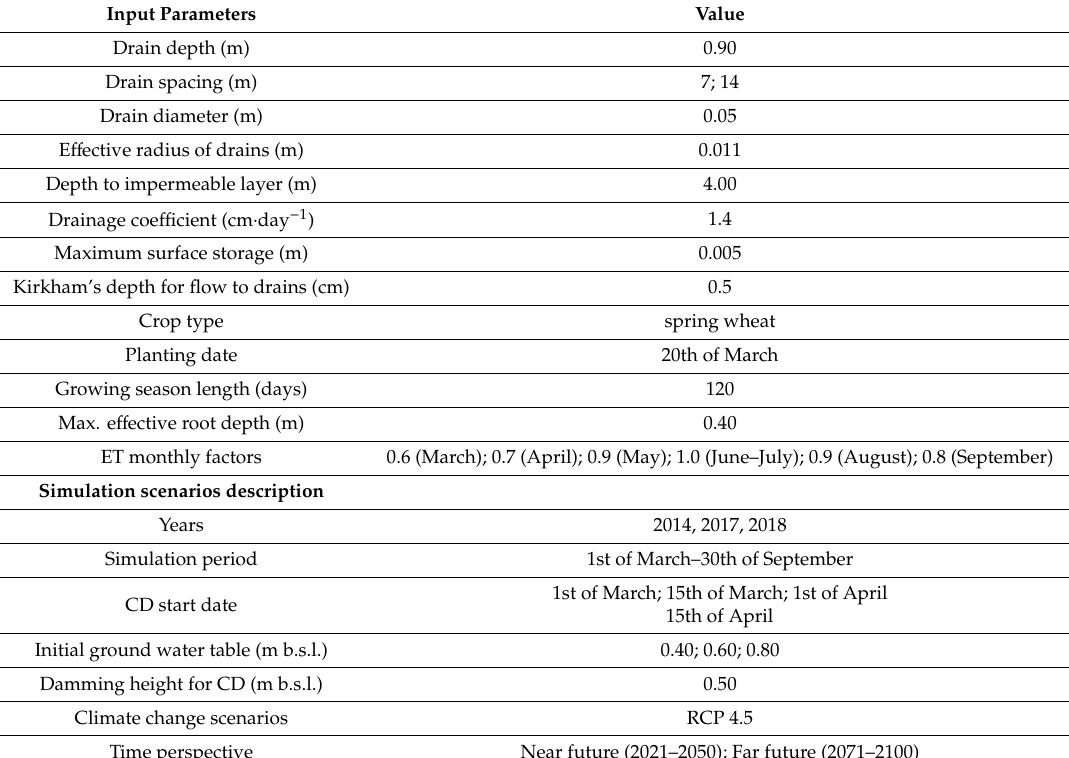
Table 2. Input parameters and simulation scenarios